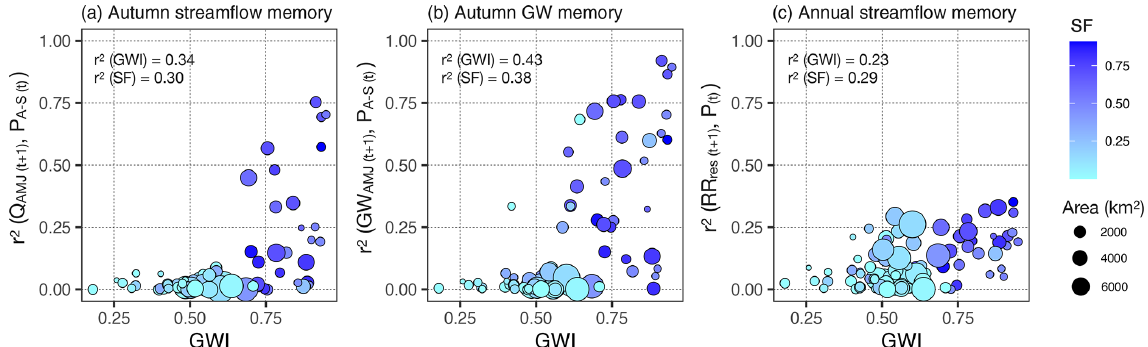
Figure 4. Relationship between hydrological memory and indices of groundwater and snow storages (GWI and SF, respectively). Panel (a) shows the autumn streamflow correlation to the autumn–winter precipitation of the preceding year (9-month memory). Panel (b) shows the autumn GW correlation to the autumn–winter precipitation of the preceding year (9-month memory). Panel (c) shows the streamflow correlation to the precipitation of the preceding year ( > 12-month